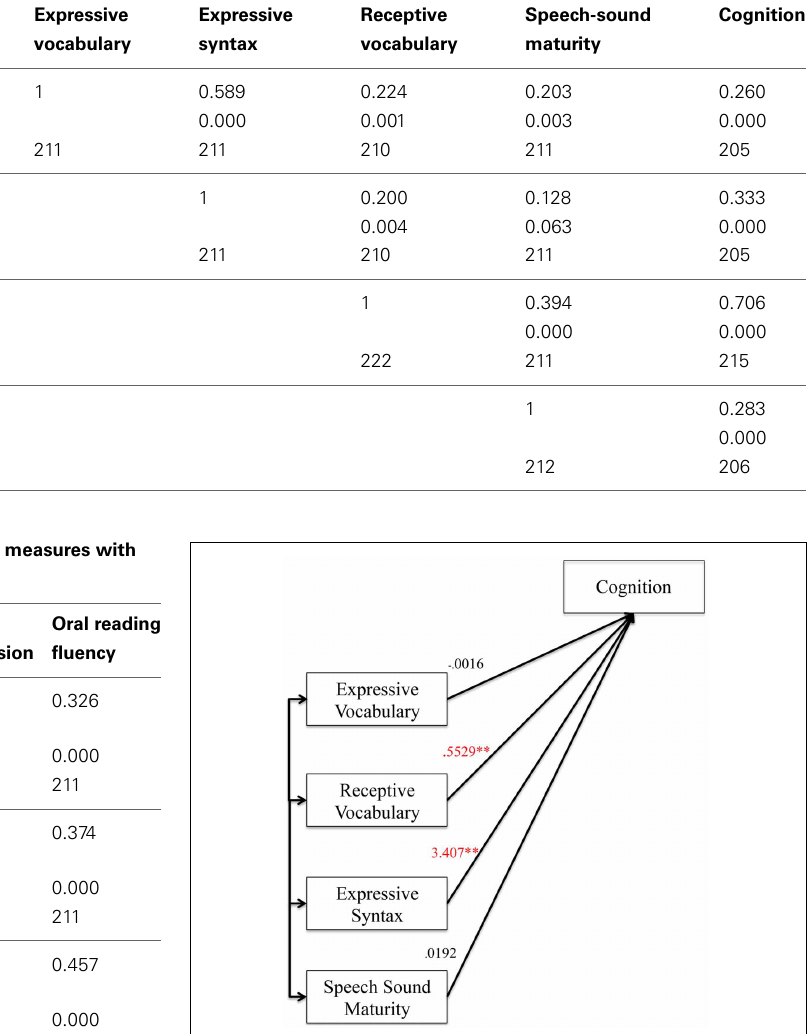
FIGURE 1 | Effect of the predictor variables on the mediator variable. Figure 1 shows the effects of preschool language and speech measures on cognition as the mediator variable. Unstandardized coefficients of correlations are included in model. Coefficients marked with a double asterisk are significant at the p < 0 . 01